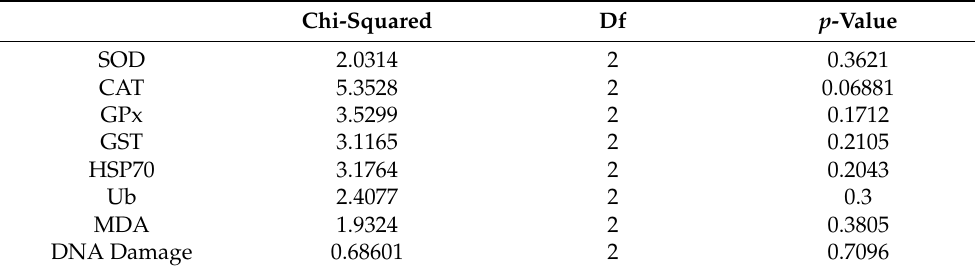
Table 4. Analysis of deviance table (Type II tests) for the generalized mixed models for oxidative stress biomarker analysis of shark embryos exposed to control, deoxygenation, and